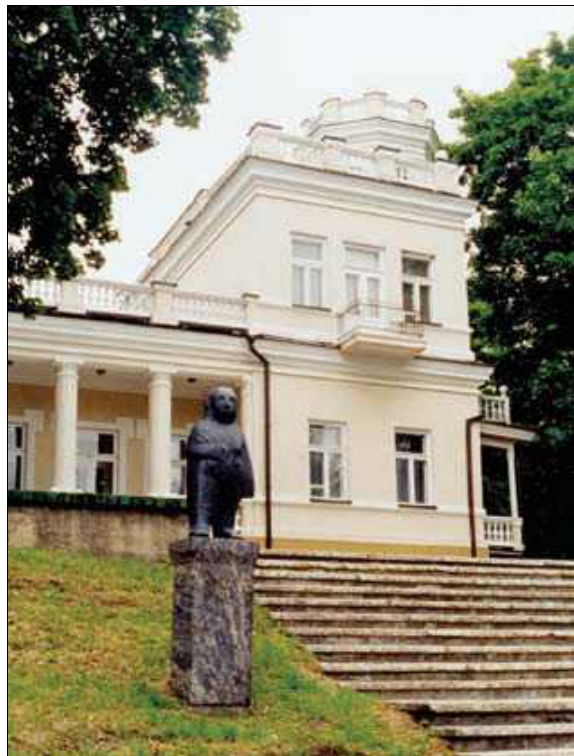
Fig. 8. Vila “Linksma” located on the bank of the Druskonis lake with a sculpture “birthday” in front (sculptor: k. Jaroševaitė,